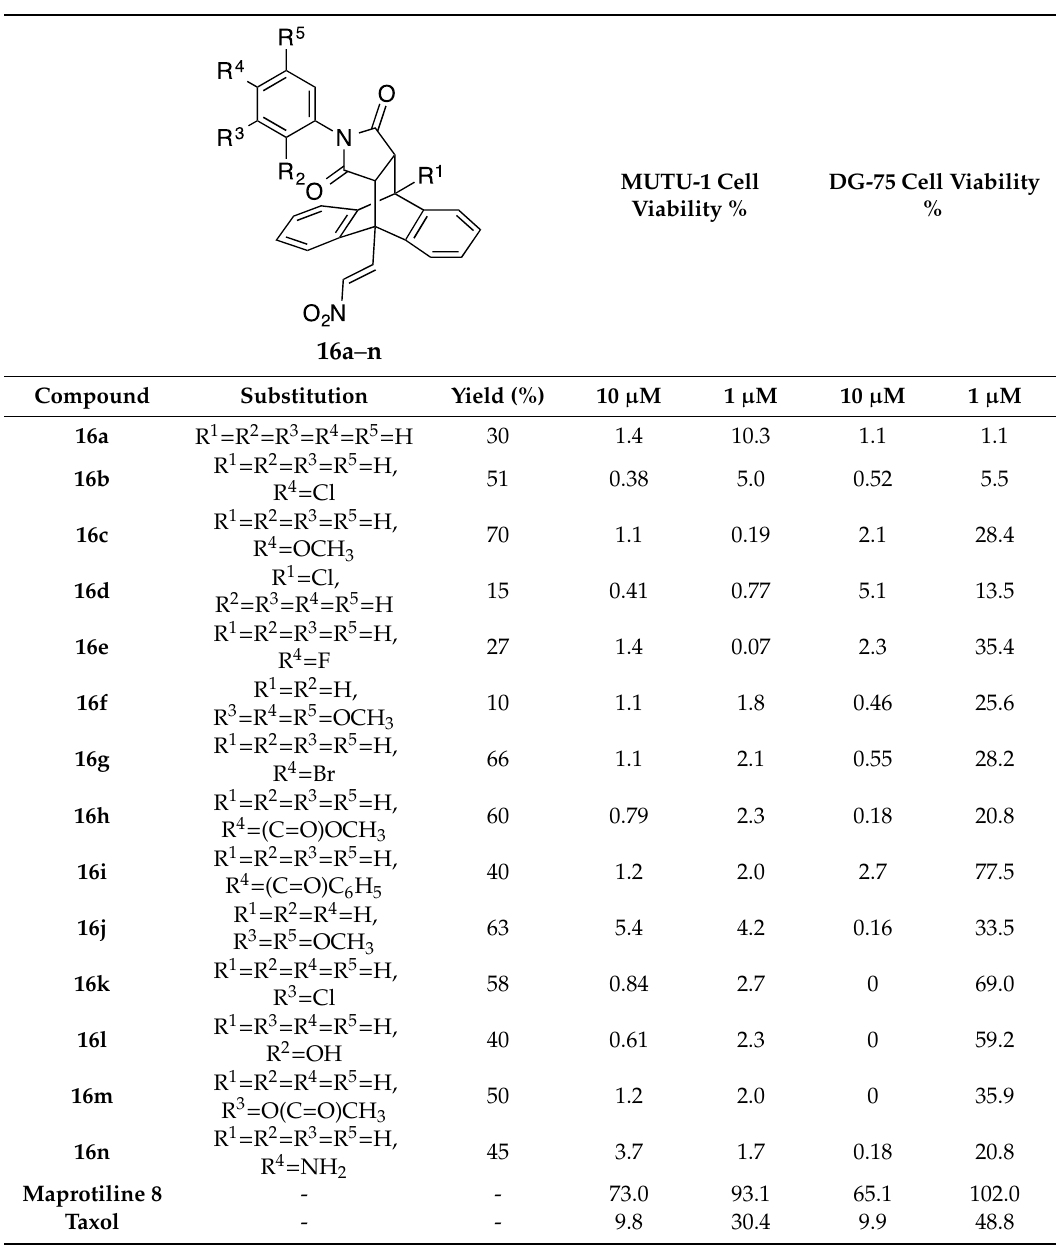
Table 2. Yields and preliminary cell viability data for compounds 16a – n (Series IIIA) in MUTU-1 and DG-75 Burkitt lymphoma cell lines.